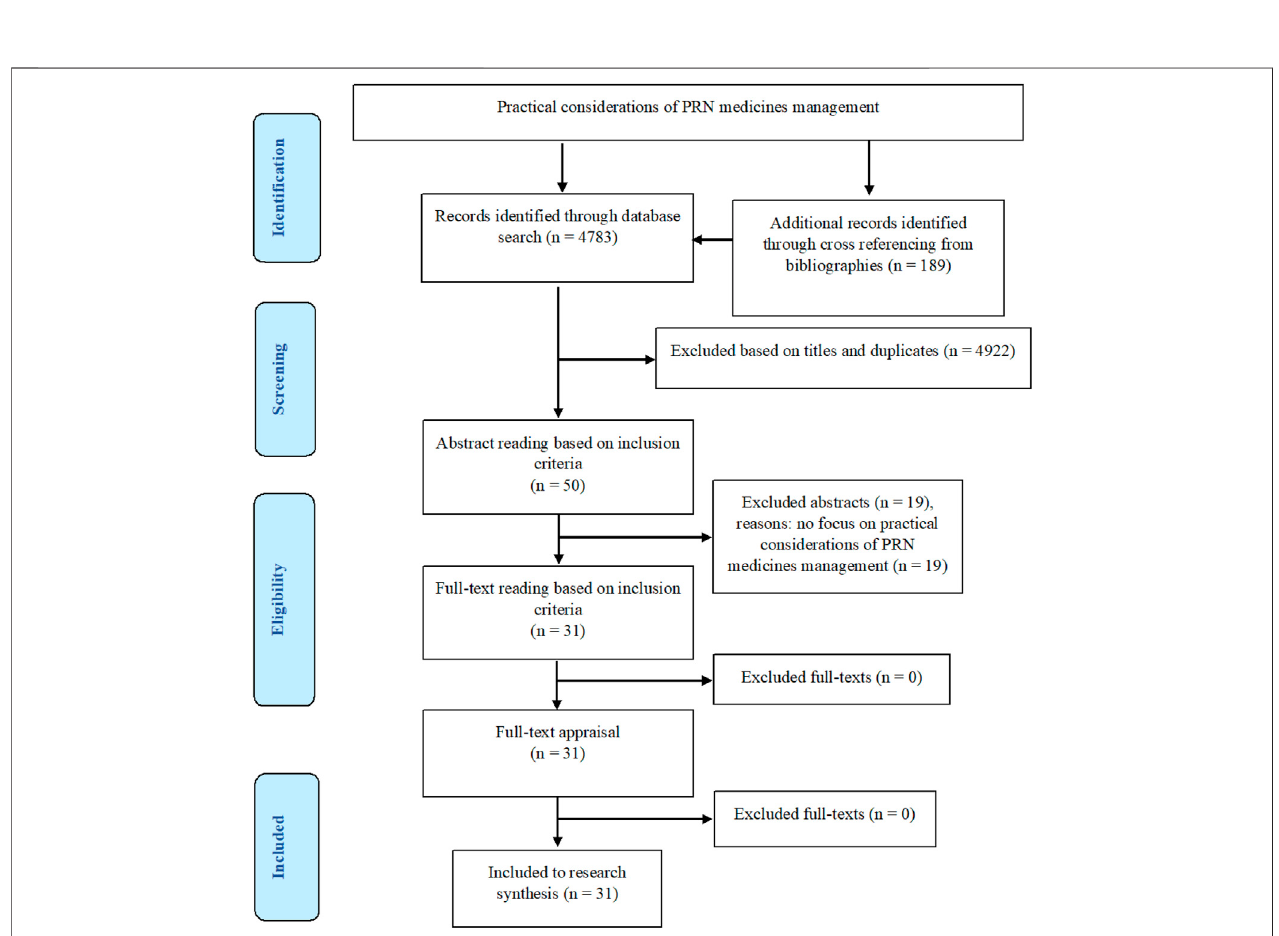
FIGURE 1 | The preferred reporting items for systematic reviews and meta-analyses